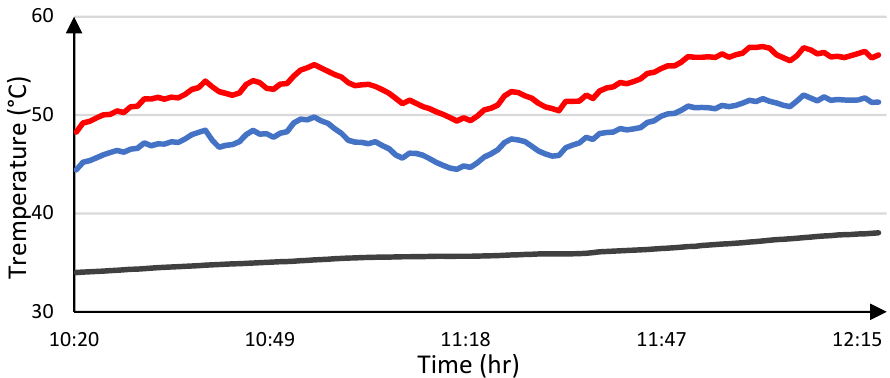
Figure 14. Temperatures during the melting process. The red line indicates the front temperature of the simple panel, the blue one the enhanced panel. The black line is the average of the two thermocouples dipped into the PCM.